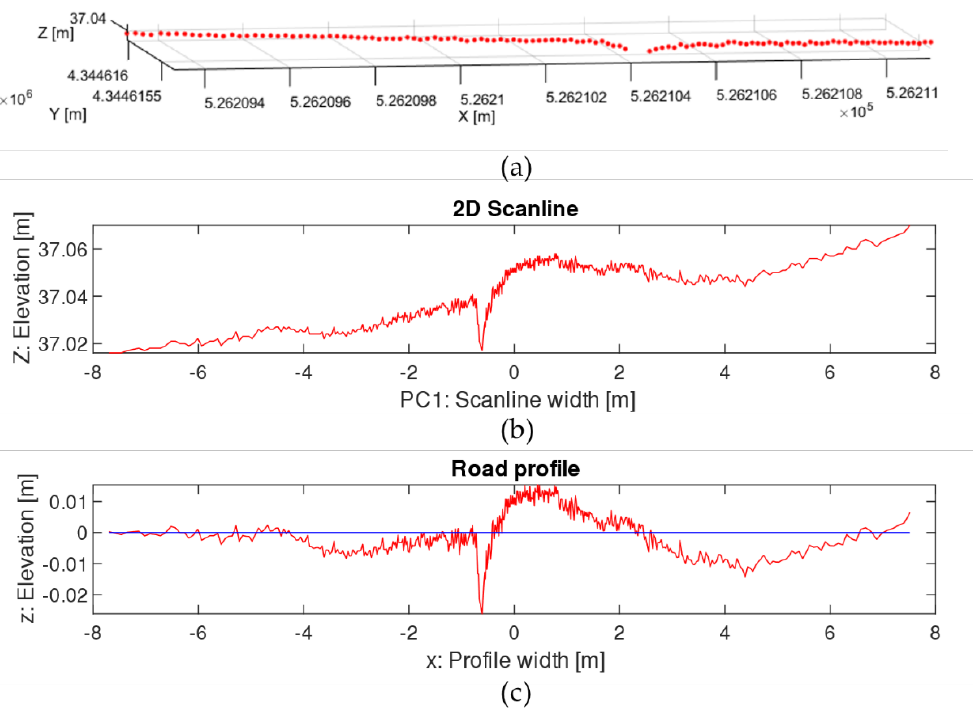
Figure 2. ( a ) Points on the original 3D scanning line. ( b ) 2D profile. ( c ) 2D profile after PCA to remove the slope.